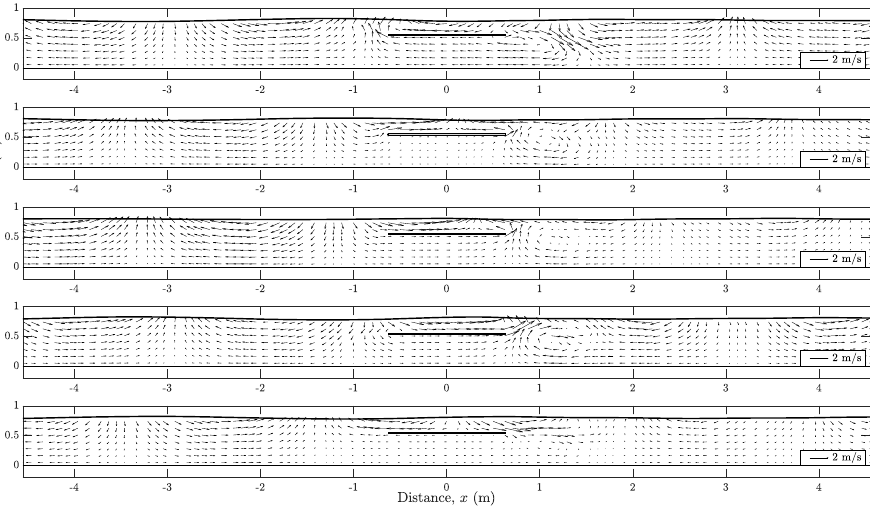
Figure 20. Submerged obstacle on a solid bed ( d m = 0 ) : snapshots of velocity field over a wave period at t / T = 1 , 2 , 3 , 4 , and 5 (top to bottom). Solid line indicates the free surface. See Figure 18 6 6 6 6 6 for the model inputs.